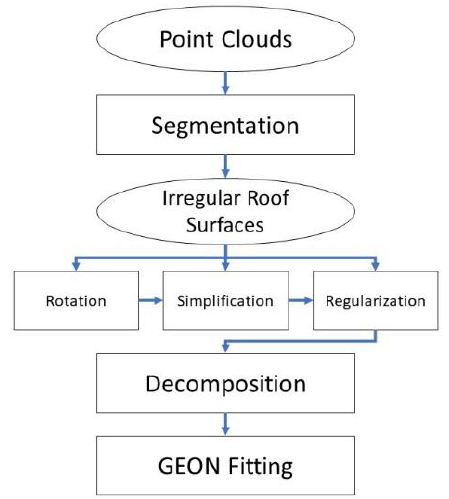
Fig 1. Workflow of shorted-edge-based polygon decomposition method (SHORTER) for building reconstruction